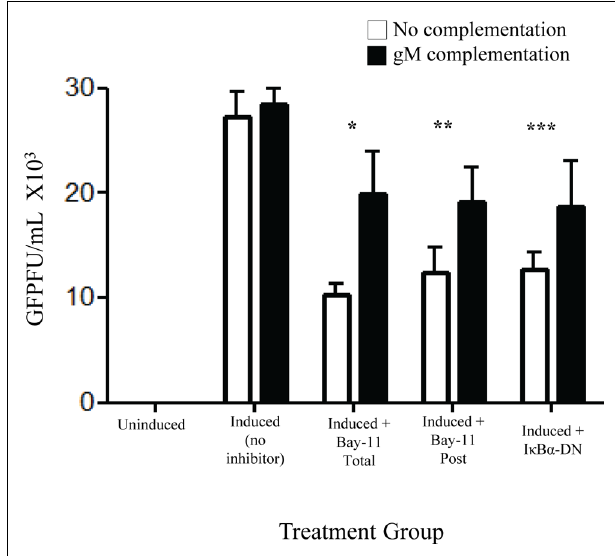
FIGURE 6 | gM complementation partially reverses loss of infectivity that results from NF κ B inhibition. rKSHV.219 infected HF cells were transfected with either vector alone ( (cid:3) ) or pIRES-2-gM ( (cid:2) ) and either mock induced or induced to undergo lytic replication.They were then either mock treated (No inhibitor), transfected with I κ B α -DN or treated with Bay11-7082 prior to induction (Total) or at time of induction (Post). Supernatants were harvested and GFP forming units on 293 were measured. Samples were run in triplicate and are representative of three separate experiments. Error bars represent standard deviations of the mean. * p < 0.0029; ** p < 0.0092; *** p < 0.0202. 1 × 10 5 cells were used per group in this